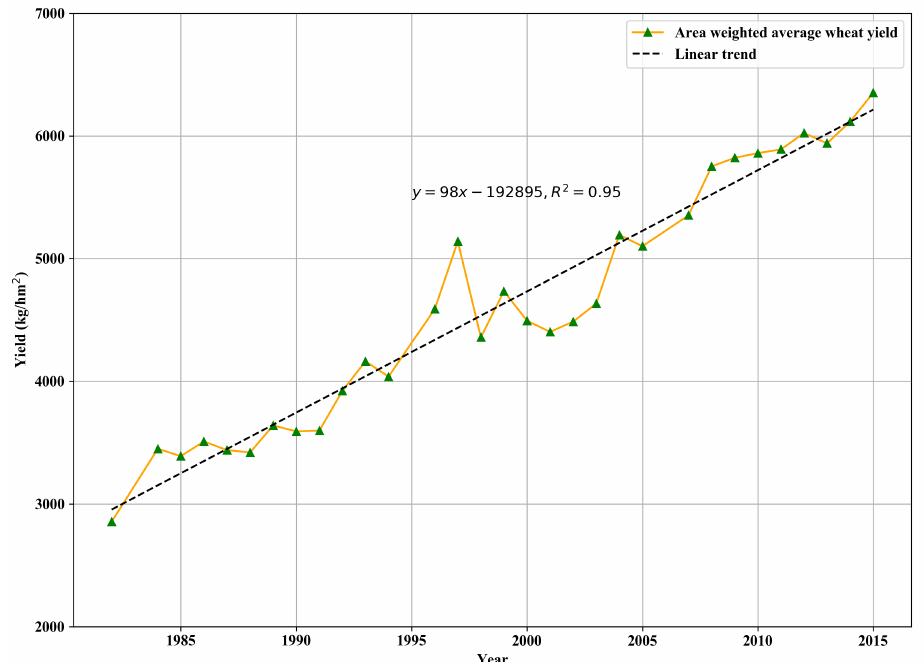
Figure 2. The yearly area weighted average yield calculated from county-level yields in the whole study area and its linear